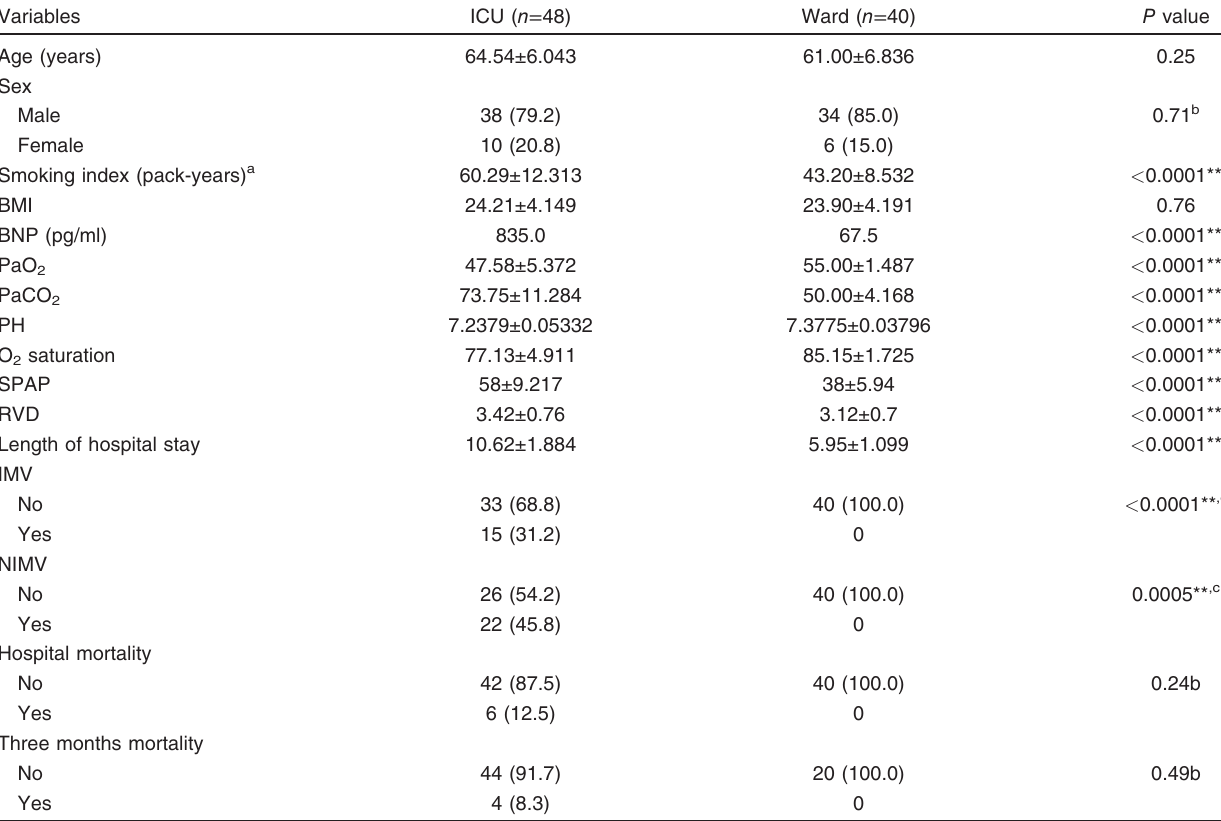
Table 2 Baseline characteristics of the patients admitted in the ICU and ward patients ( n = 88) Variables